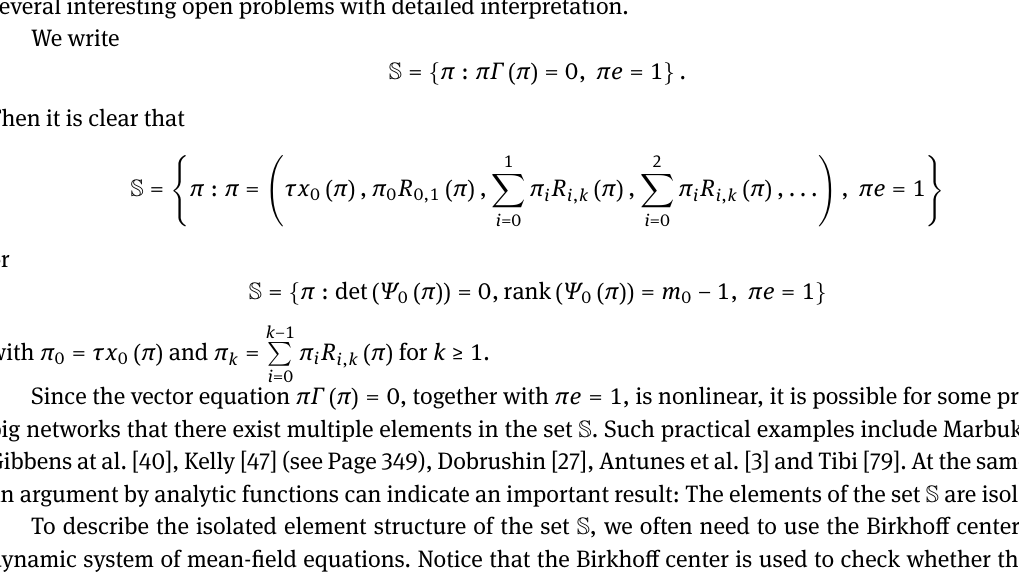
Algorithm II: Computation of the fixed